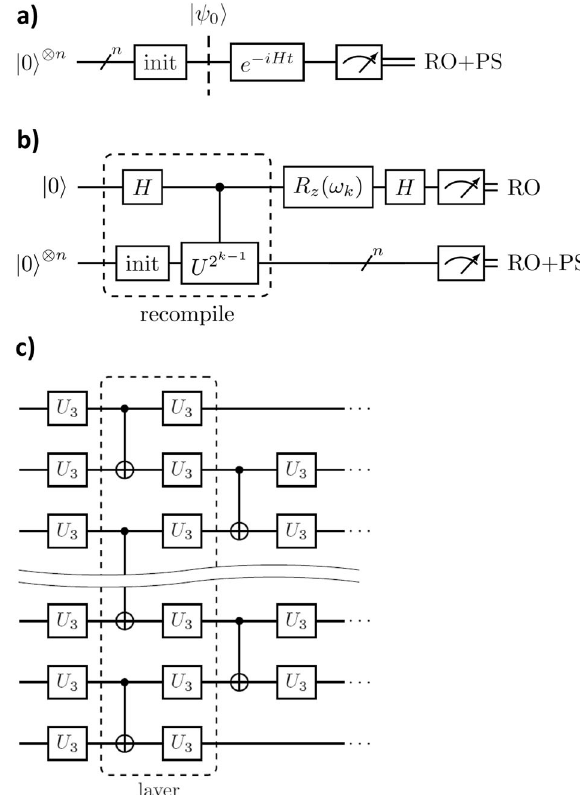
Fig. 5 Quantum circuit diagrams. Quantum circuit schematics for a time-evolution and b iterative quantum phase estimation (IQPE) for reconstructing band structure eigenergies. c Circuit recompilation ansatz for the propagator e − iHt , comprising an initial layer of U 3 gates and successive layers of CXs and single-qubit rotations. Note that H in b refers to the Hadamard